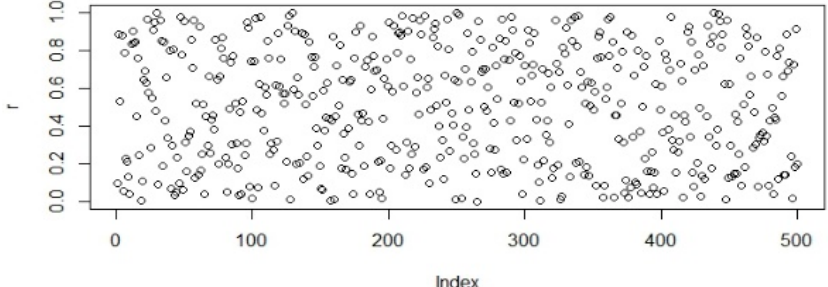
Figure 1. Population initialization using the uniform distribution .